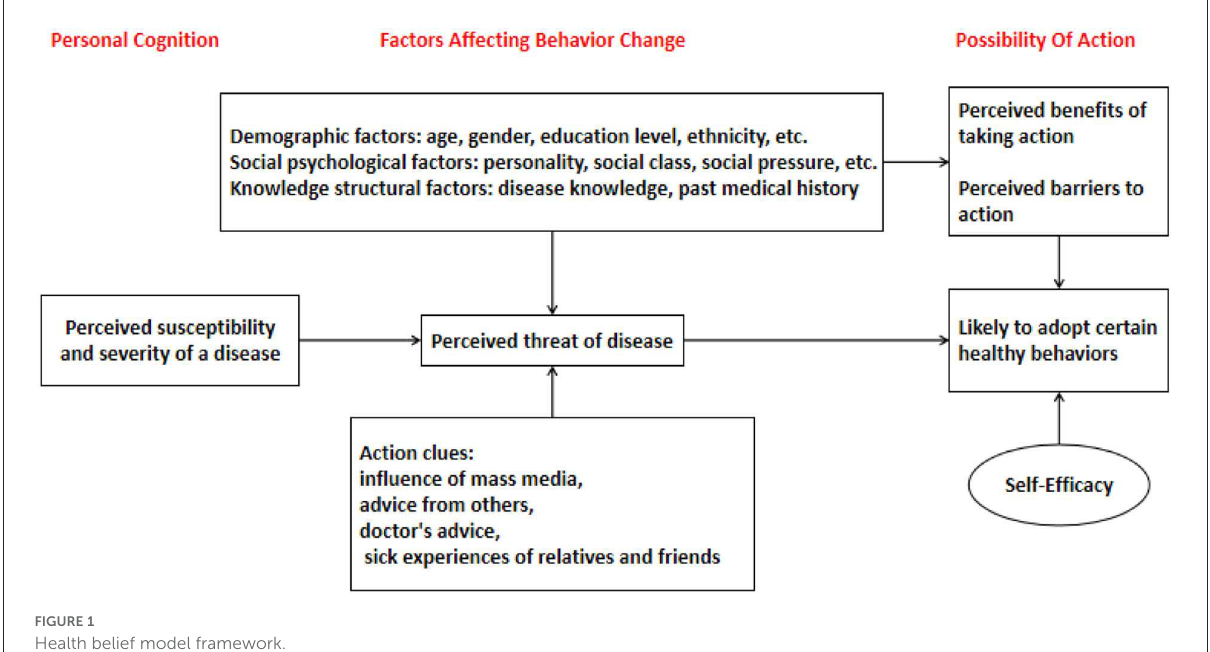
FIGURE1 Health belief model framework.